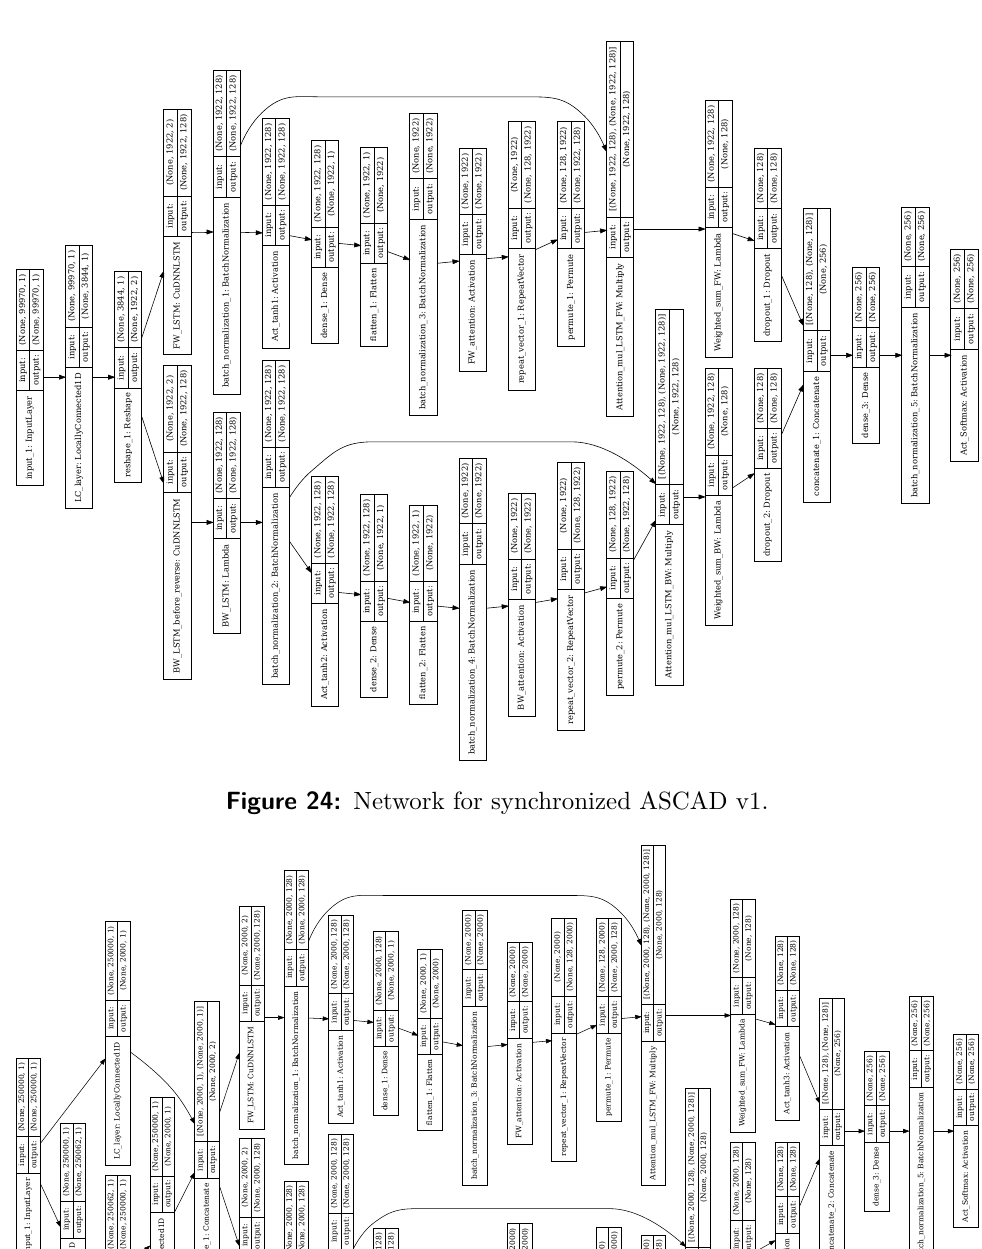
Figure 25: Network for synchronized ASCAD